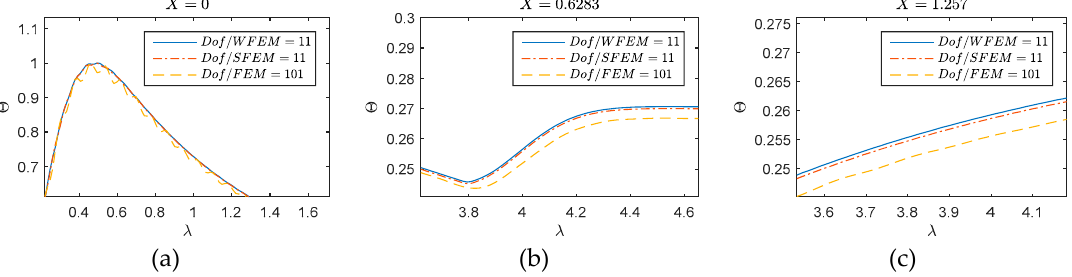
Figure 4. Comparisons on accuracy and efficiency among FEM, spectral finite element method (SFEM), and wavelet finite element (WFEM): ( a ) X = 0; ( b ) X = 0.6283; ( c ) X = 1.257.